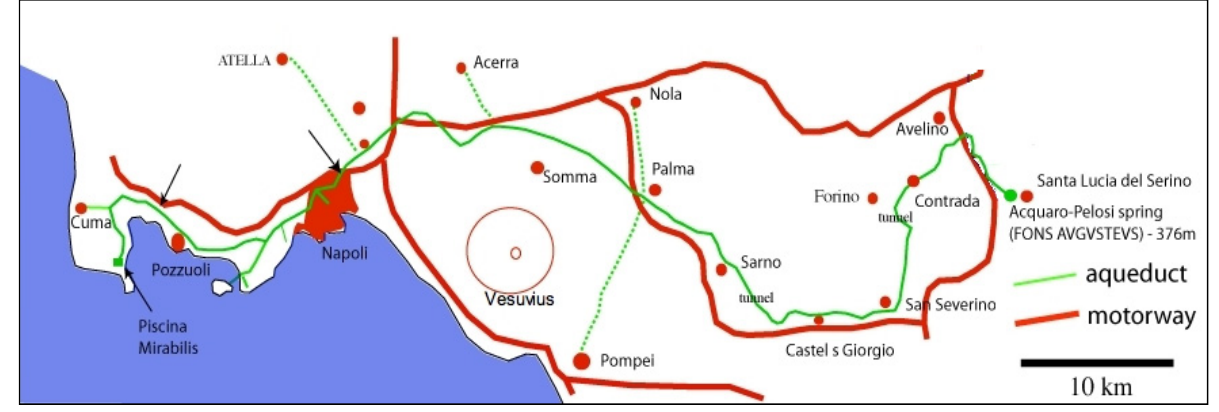
Figure 14. Serino aqueduct in the Campania region of Southern Italy.